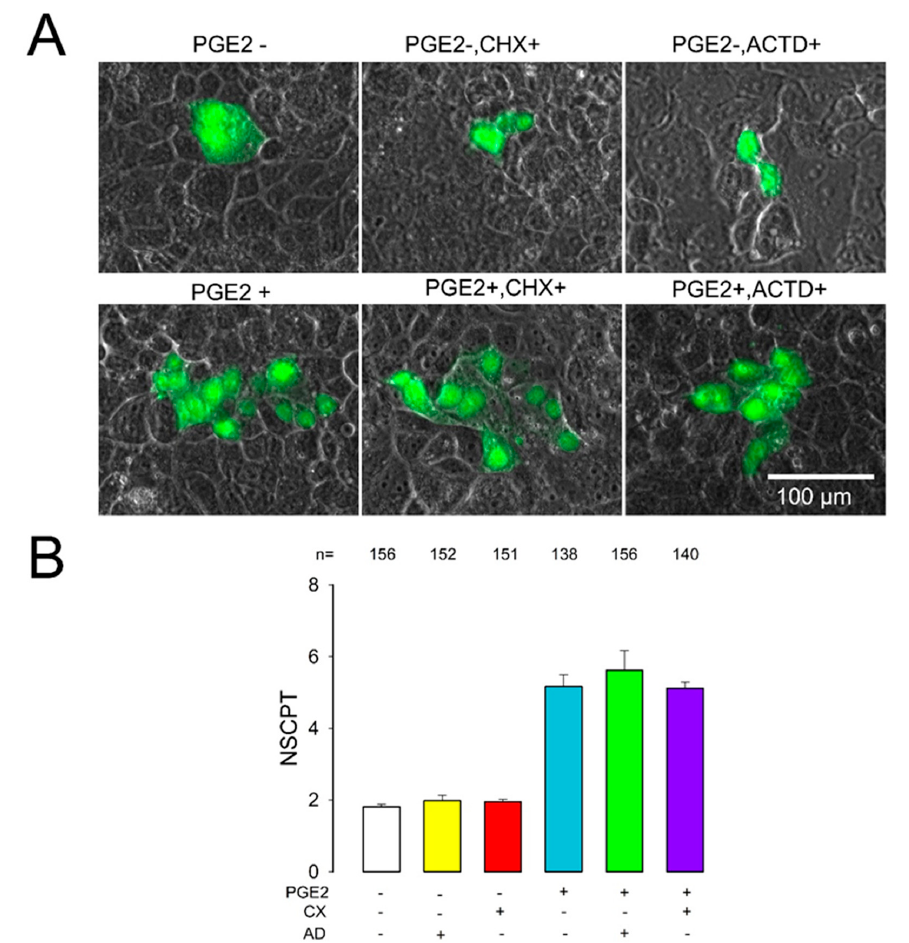
Figure 3. PGE2-induced enhancement of GJIC does not involve synthesis of new subunits. ( A ) Representative images show clusters of cells stained (green) after one of them had been injected with Lucifer yellow. Each image was selected to match the median of the NSCPT obtained from a number of repeats under each experimental condition indicated. ( B ) The bar chart represents the average (NSCPT) under each experimental condition indicated at the bottom. Comparisons of PGE2 vs. PGE2+AD and PGE2 vs. PGE2+CX were not statistically significant. The numbers above each bar indicate the number of repeats under each experimental condition.